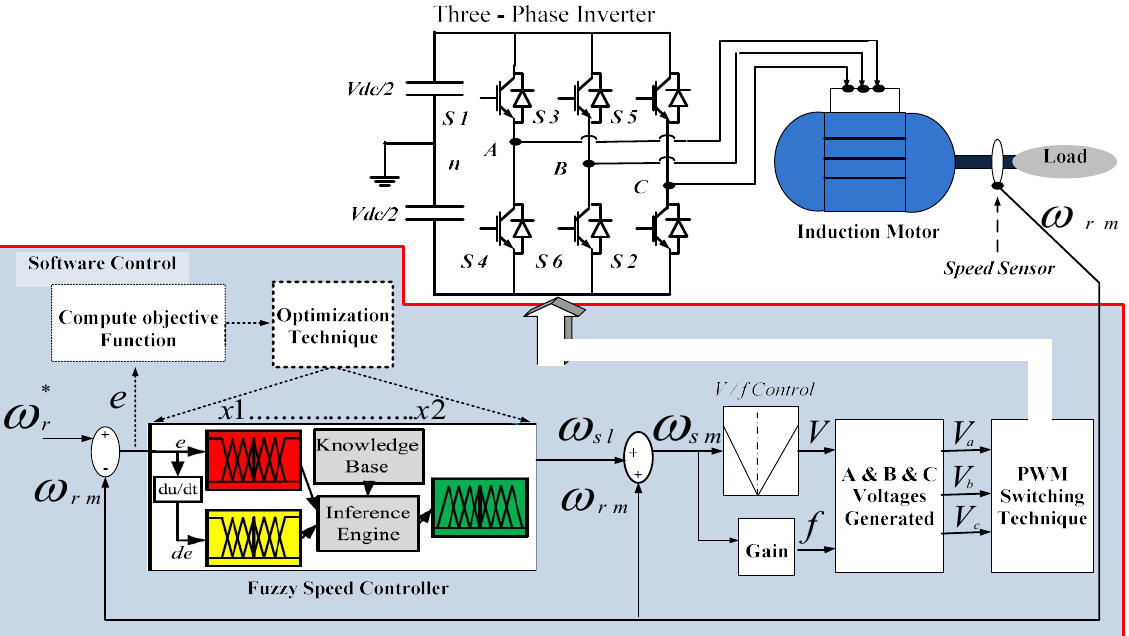
Figure 17. Optimization technique for scalar control based on FL speed controller.